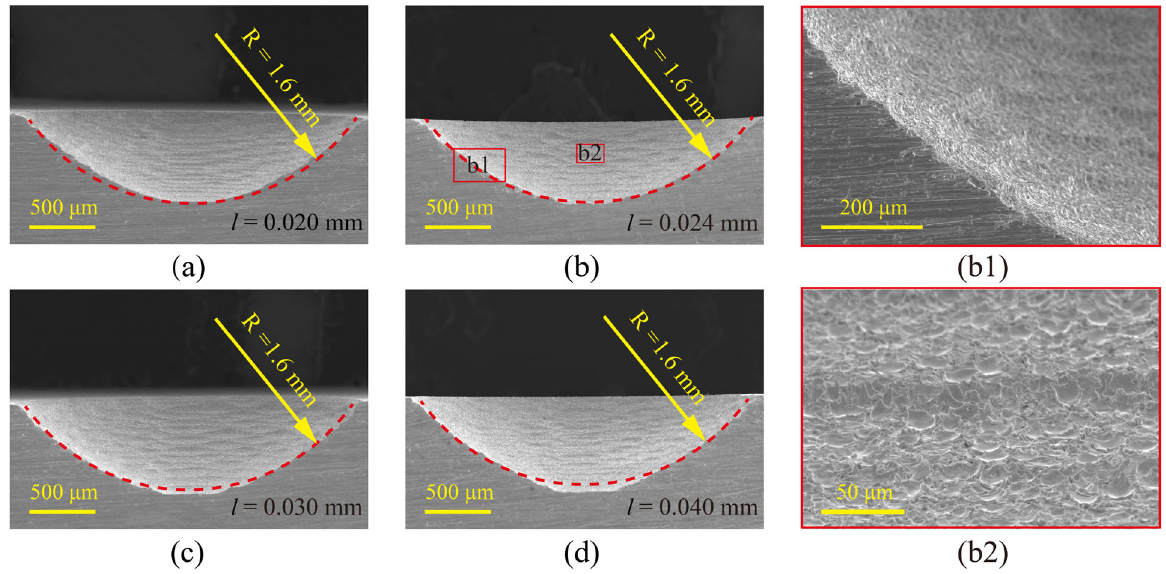
Figure 8. Section and partial enlargement of ball socket under different initial layer thicknesses. ( a ) l = 0.020 mm; ( b ) l = 0.024 mm; ( c ) l = 0.030 mm; ( d ) l = 0.040 mm; ( b1 ) and ( b2 ) are the local magnification of ( b ).